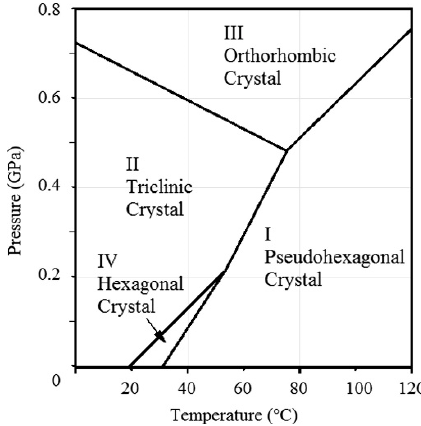
Figure 12. PTFE phase diagram at low pressure